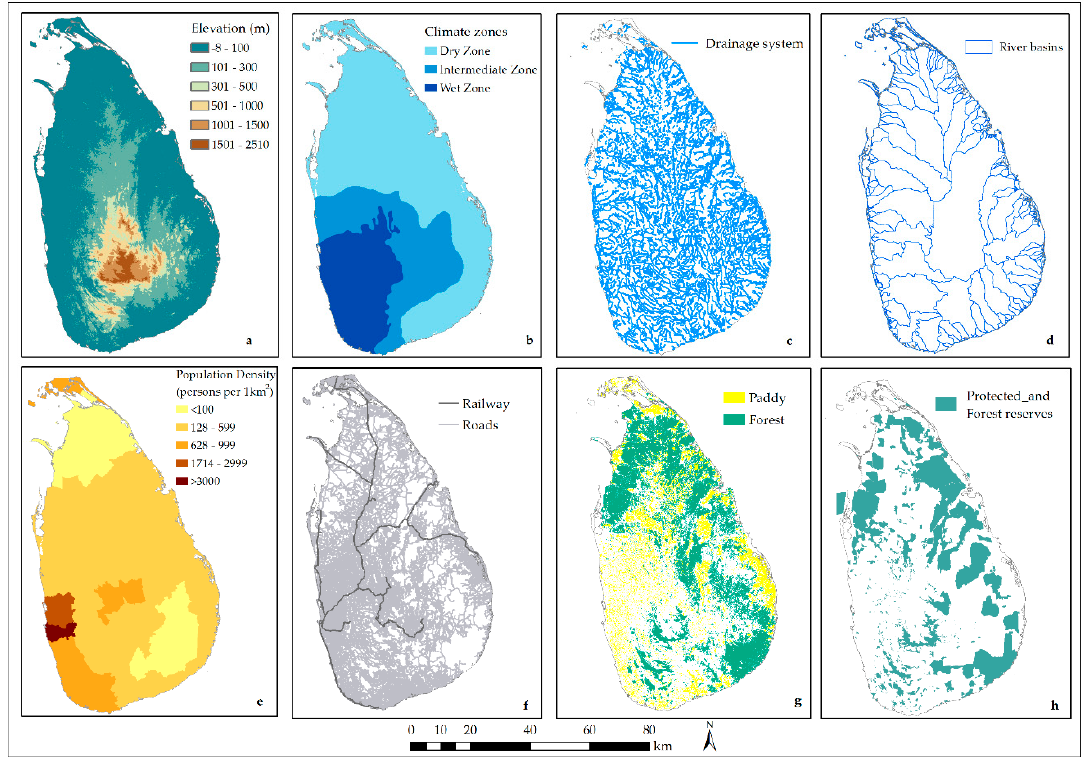
Figure 2. Physical and cultural characteristics in Sri Lanka: ( a ) elevation [50], ( b ) climate zones, ( c ) drainage [51], ( d ) river basins [52], ( e ) population density as reported in 2012 [53], ( f ) railway and road network, ( g ) paddy and forest cover as reported in 2007 [54] and ( h ) protected areas as reported in 2010 [55].